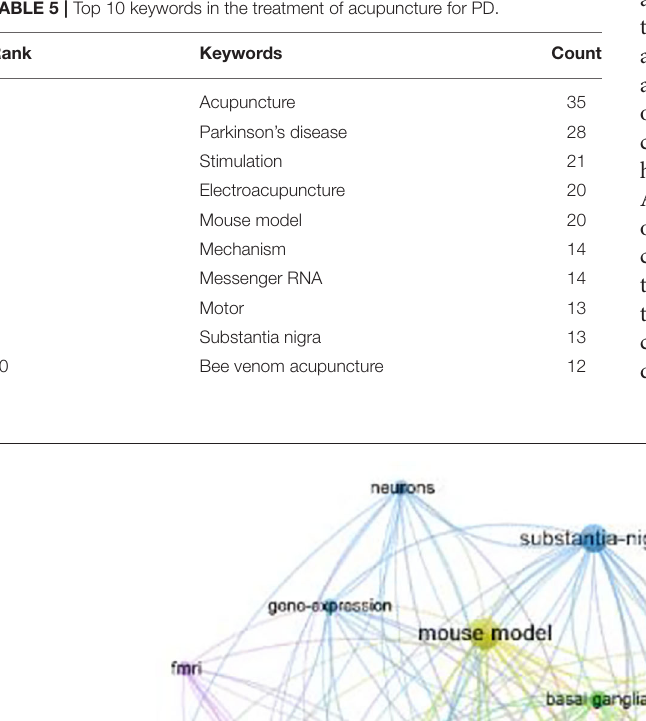
Frontiers in Neurology |